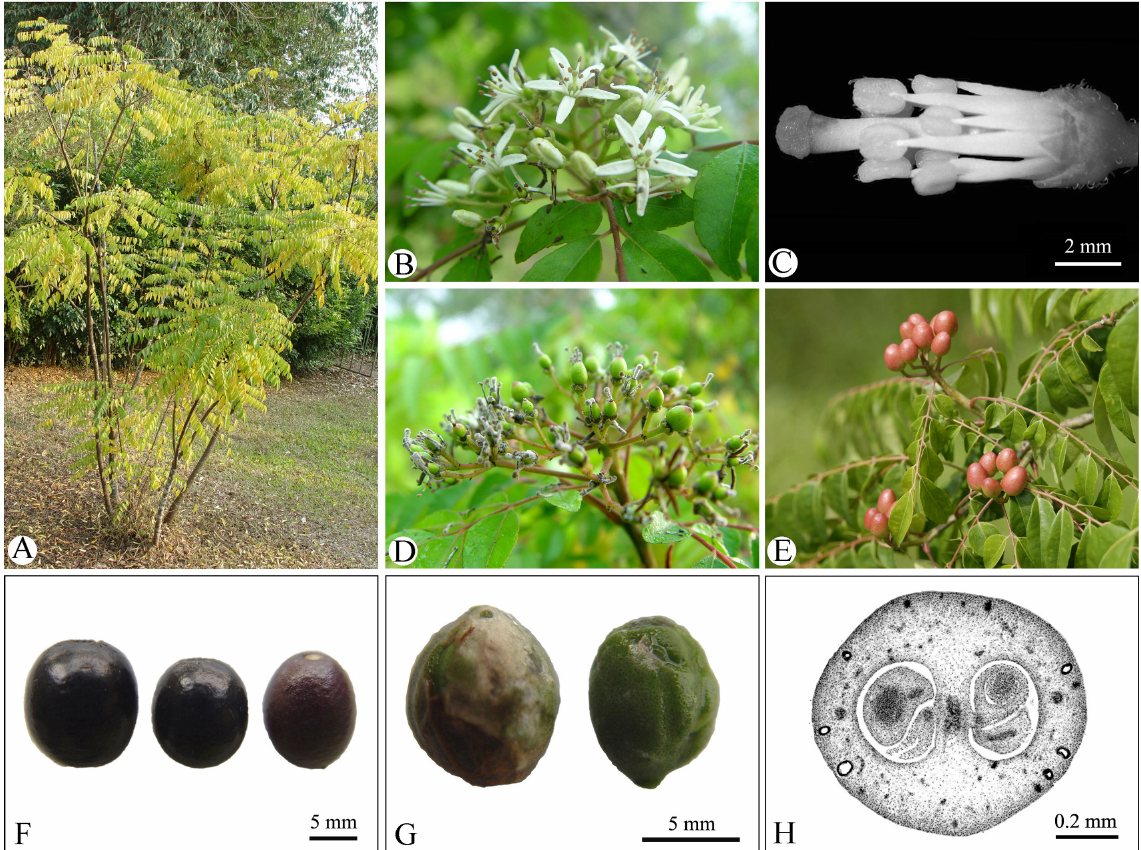
Fig. 7. Bergera koenigii L. A . Plants. B . Inflorescence. C . Pistil and stamens. D–E . Infructescence. F . Fruits. G . Seeds. H . Ovary crossection. Photos taken by Feng-Juan Mou in